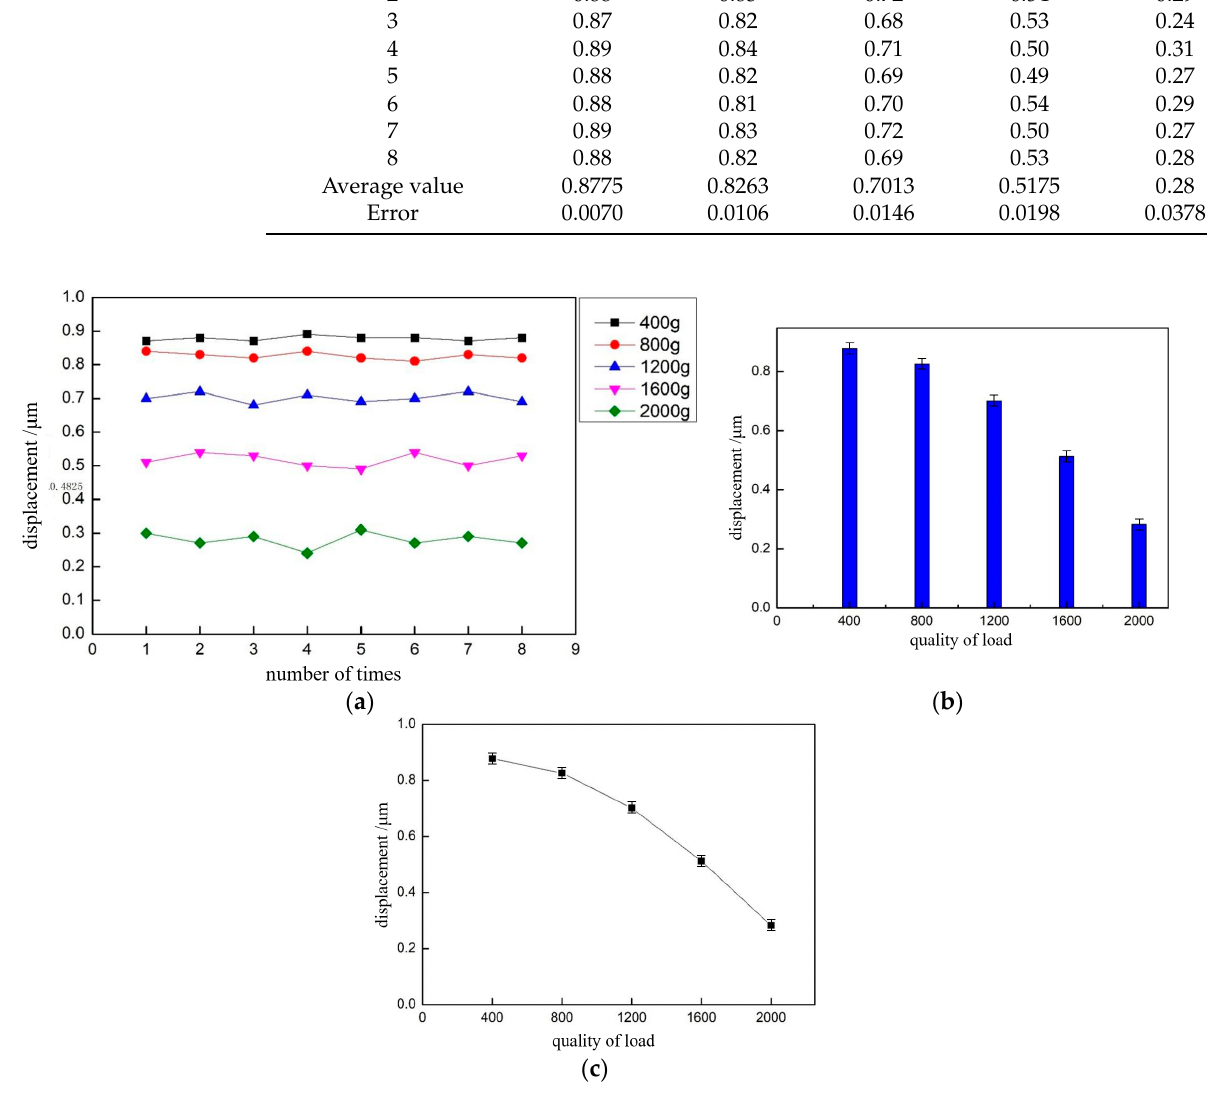
Figure 16. Output displacement of the positioning stage under different loads. ( a , b ) The relationship between output displacement of nanopositioning stage and load quality. ( c ) The relationship between the forward motion speed of nanopositioning stage and the load quality Table 2. Positioning stage output displacement data at different loads.